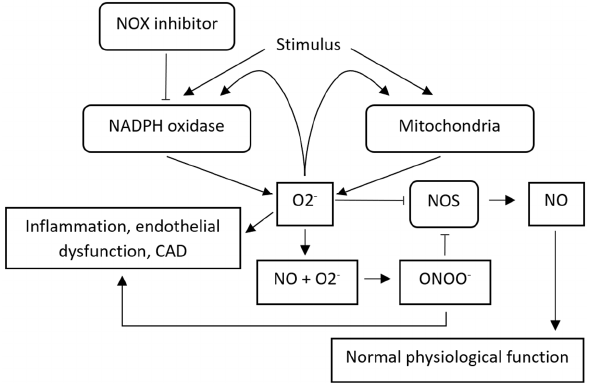
Figure 2. Sequence of events illustrating interactions between NADPH oxidases, mitochondria, (endothelial) NOS and their products in vascular health and disease. While excess ROS produced from NADPH oxidases contributes to pathology, note that increased activation of some NOX isoforms, such as NOX4, may serve a cardioprotective function [64]. Examples of NOX inhibitors include GKT137831, Setanaxib, and apocynin.